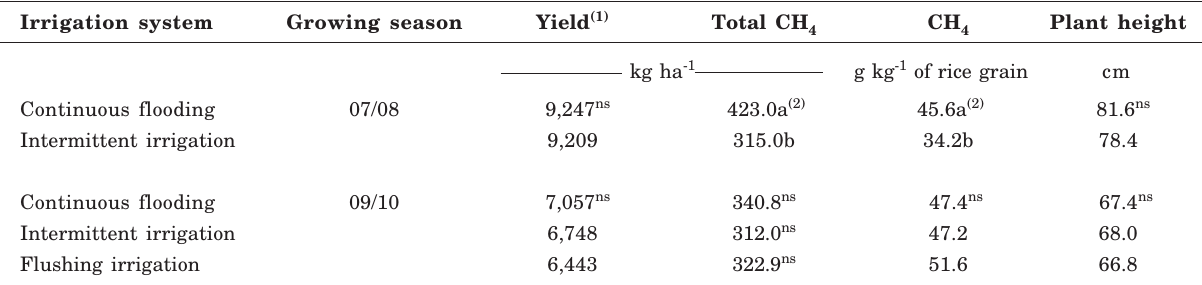
Table 1. Rice yield, total methane emission, methane emission per rice grain production and plant height in different irrigation managements in 2007/08 and 2009/10 growing